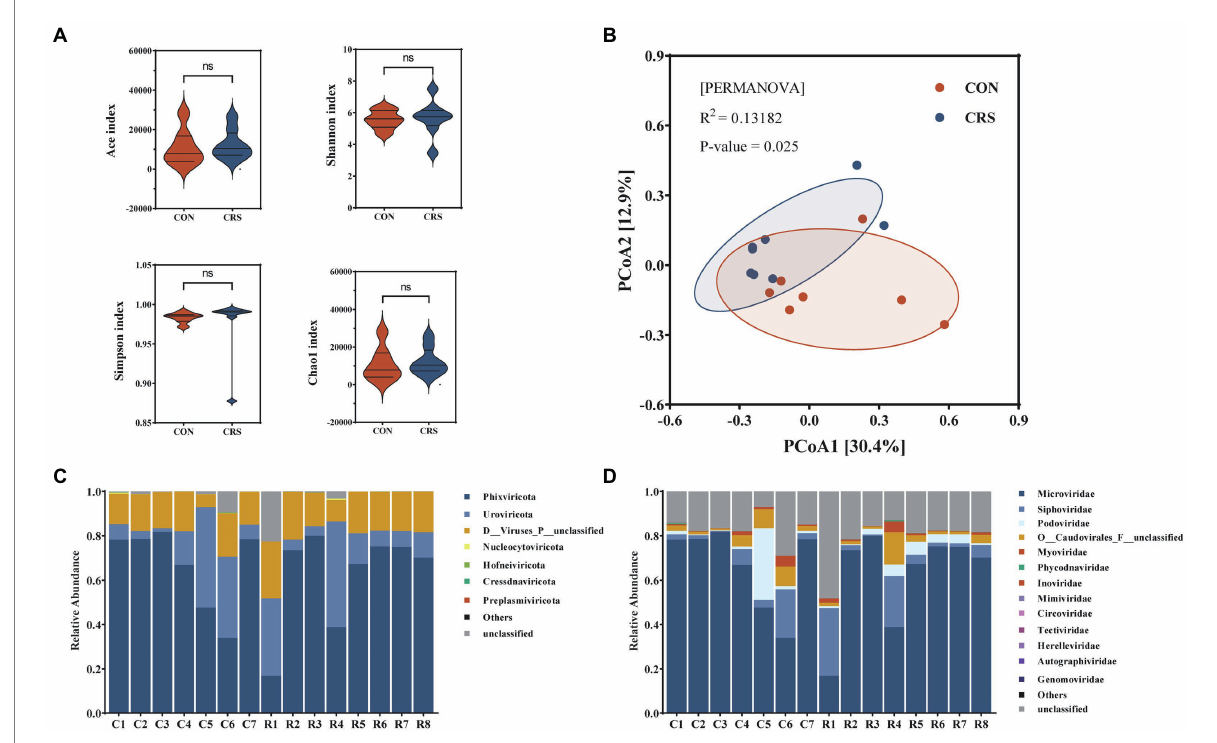
FIGURE 2 Comparison of viral community diversity and composition at contigs level between the two groups. (A) Alpha-diversity presented by Ace, Shannon, Simpson, and Chao1 index. No significant differences were detected. (B) Beta diversity visualized using a PCoA plot with Bray–Curtis dissimilarity distances. Compositions of the viral communities at the phylum level (C) and family level (D)